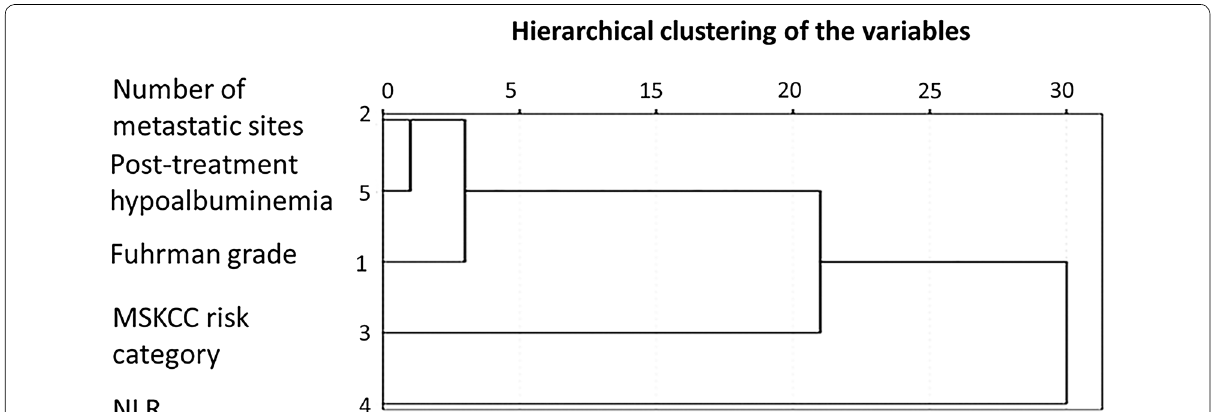
Fig. 3 Hierarchical clustering of the variables associated with post-treatment hypoalbuminemia. The hierarchy dendrogram of five significant prog- nostic factors using average linkage method indicates that post-treatment hypoalbuminemia is most highly associated with number of metastatic sites. NLR, neutrophil-to-lymphocyte ratio; MSKCC, Memorial Sloan Kettering Cancer